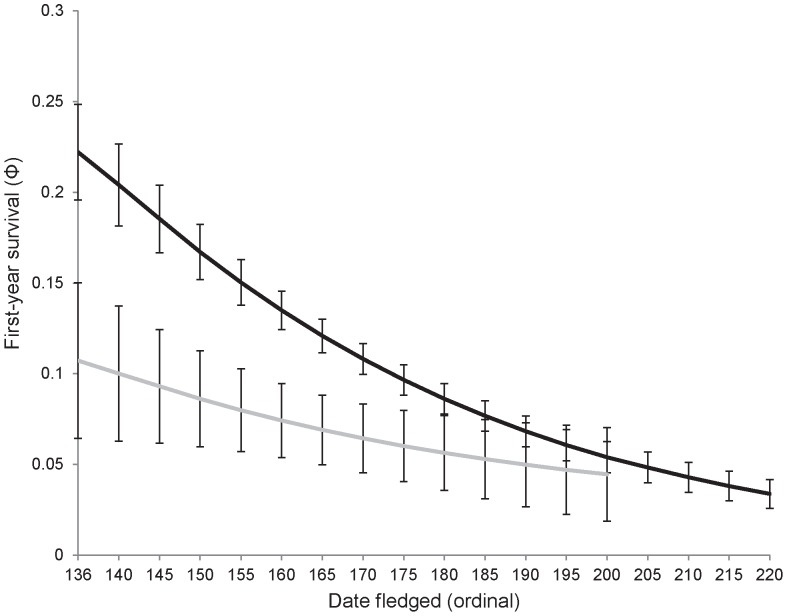
The relationship between fledge date (ordinal fledging date 136 = 15 May) and first-year survival for Prothonotary Warblers.Model averaged estimates (mean  1SE) of warblers reared with Brown-headed Cowbirds (grey line) and in the absence of cowbirds (black line) in southern Illinois, USA, fledging during 2004–2009 are presented. All other variables were held at mean observed values.